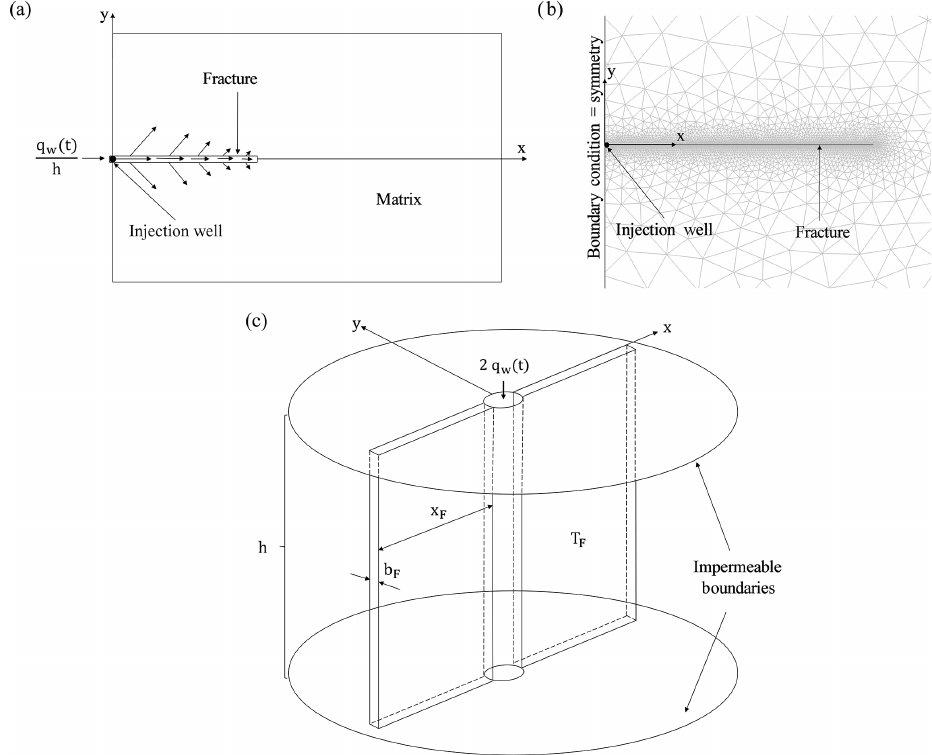
Figure 1. (a) Two-dimensional representation of model structure; (b) mesh utilized for simulation; and (c) 3D representation of model